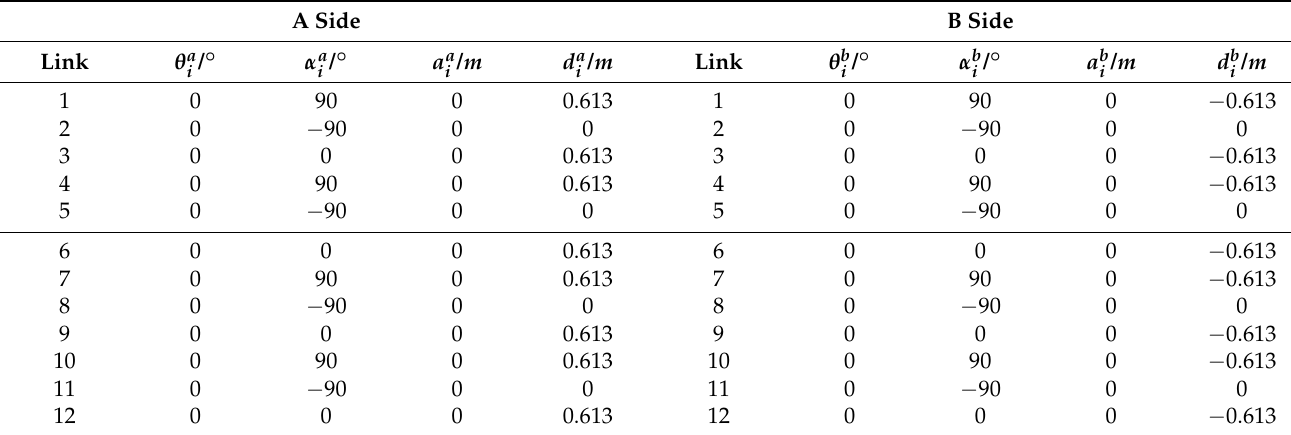
Table 1. D-H parameters of MSRS linkage coordinate system. A Side B